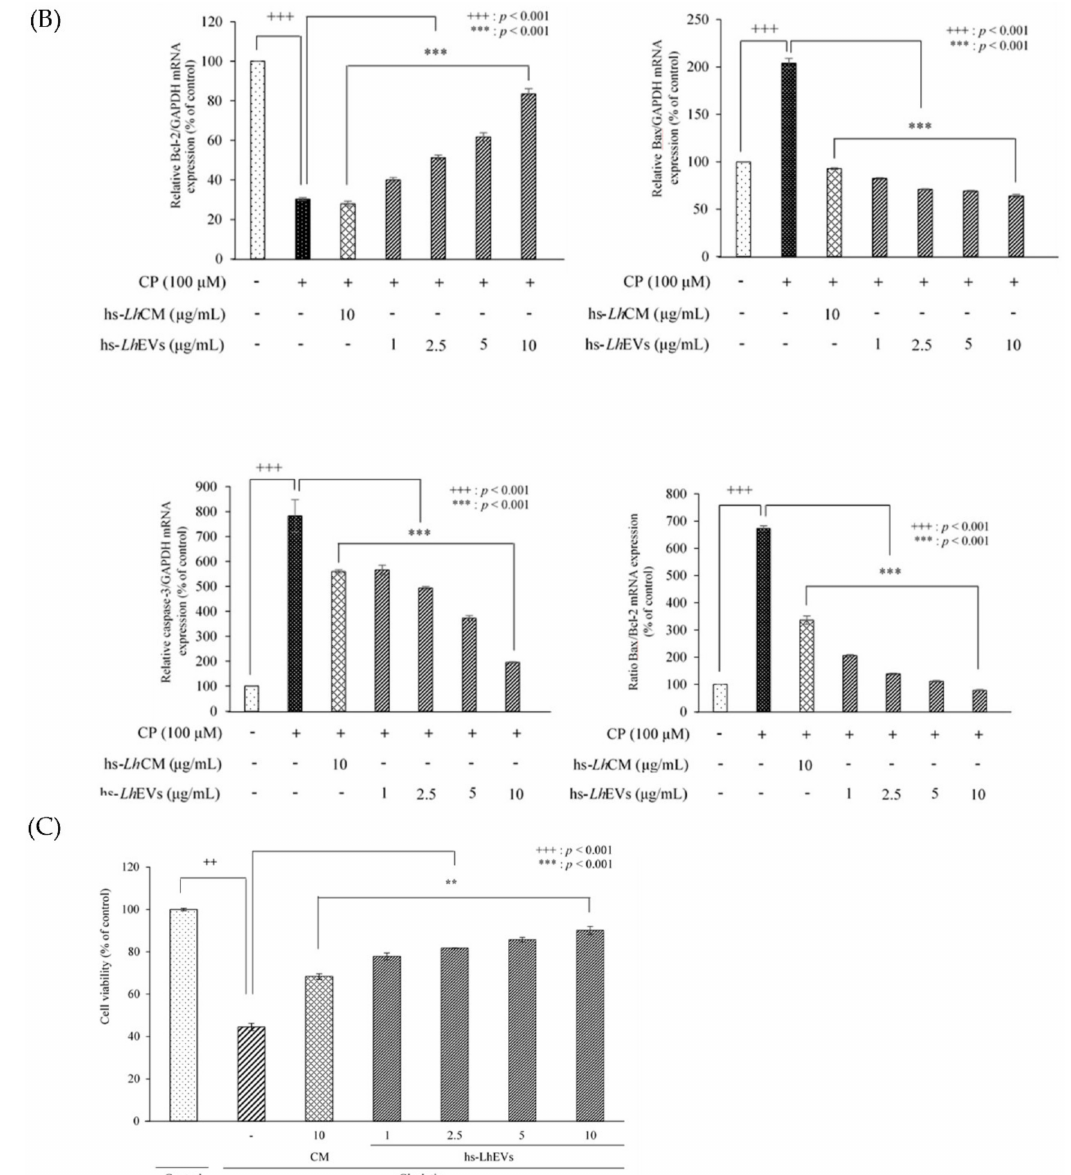
Figure 6. Evaluation of the effects of hs- Lh EVs on the Bcl - 2 , Bax , and caspase - 3 mRNA expression levels using RT-PCR in cisplatin-induced HFDPCs. ( A ) The Bcl - 2 , Bax , and caspase - 3 expression levels in HFDPCs after 24 h of treatment. ( B ) Quantification of mRNA expression shown in ( A ). ( C ) Cell viability of hs- Lh EVs in cisplatin-induced HFDP cells. Data are reported as mean ± SD of three independent experiments. Statistical analysis was performed with Student’s t -test at significance levels of ++ p < 0.01 (compared to control); ** p < 0.01 (compared to hs-LhEVs non-treatment); +++ p < 0.001 (compared to control); *** p < 0.001 (compared to hs- Lh EVs